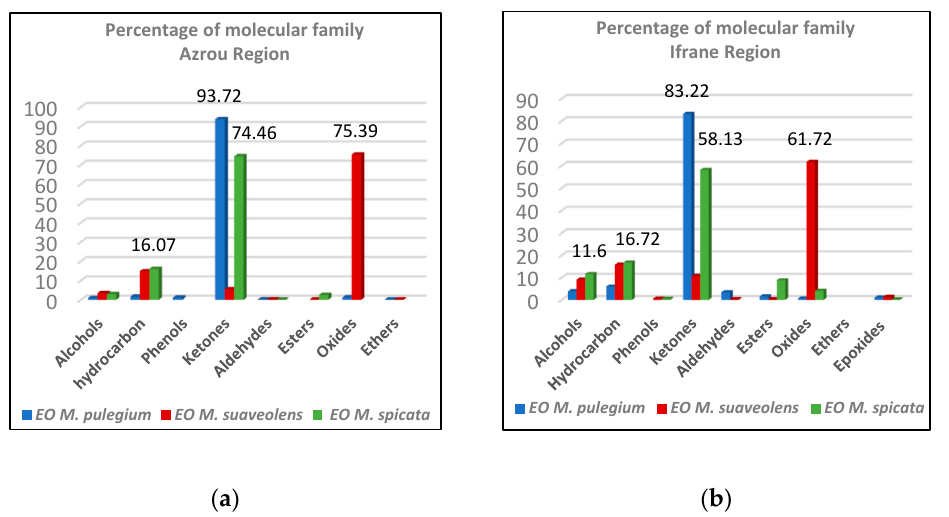
Figure 3. Percentages of chemical families of the studied Mentha species: ( a ) region of Azrou; ( b ) region of Ifrane.